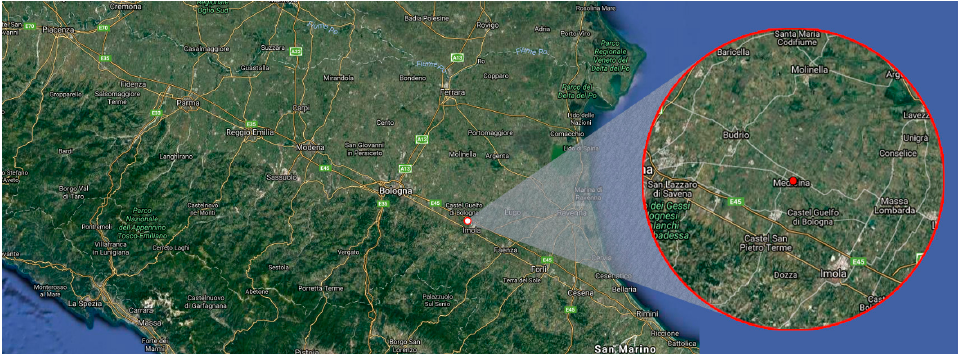
Figure 1. Case study area, 50 km diameter.